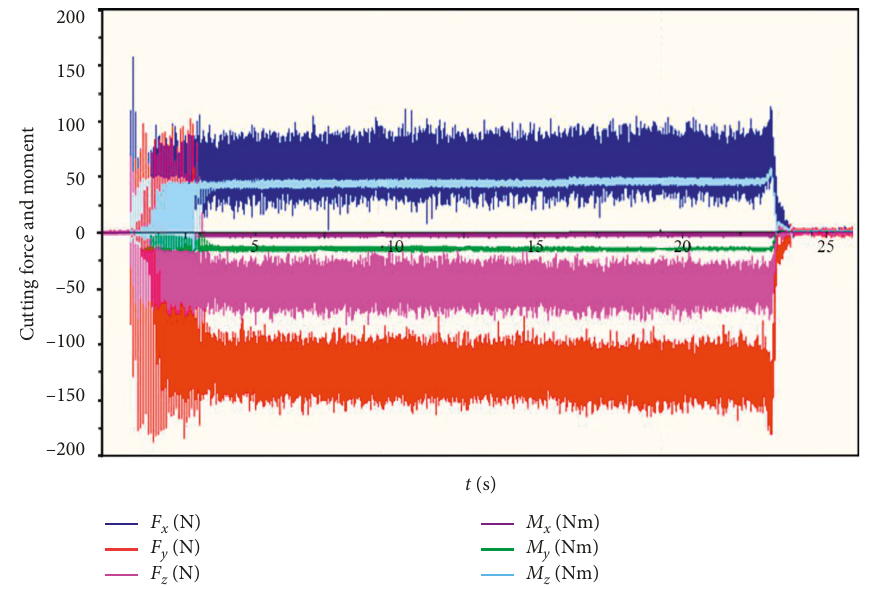
Figure 17: Stable